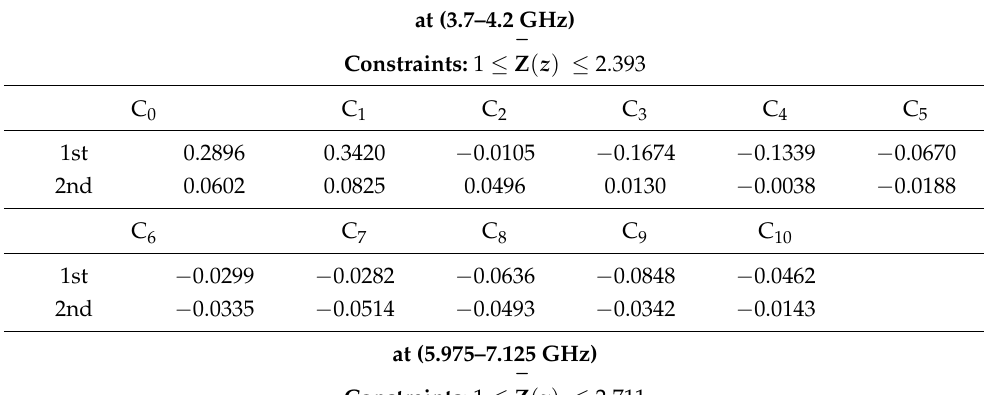
Table 2. Optimized Fourier coefficients for λ /4 NTL IBPF’s